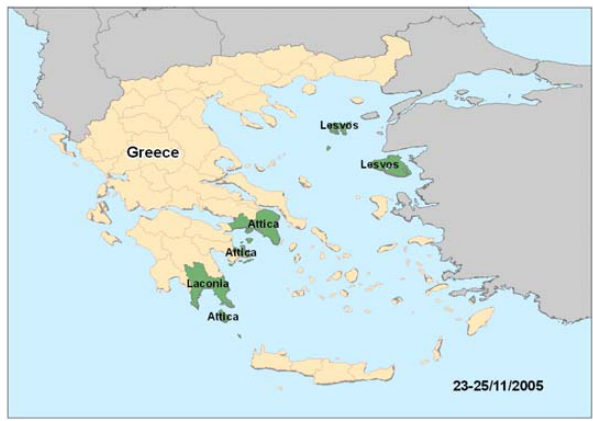
Fig. 7 . Map of Greece with the affected areas in the event of 23-25 November 2005. Fig. 7. Map of Greece with the affected areas in the event of 23– 25 November